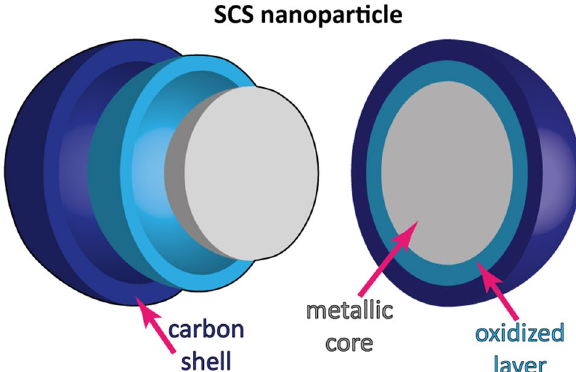
Figure 9. Simplified scheme of the SCS NP structure.